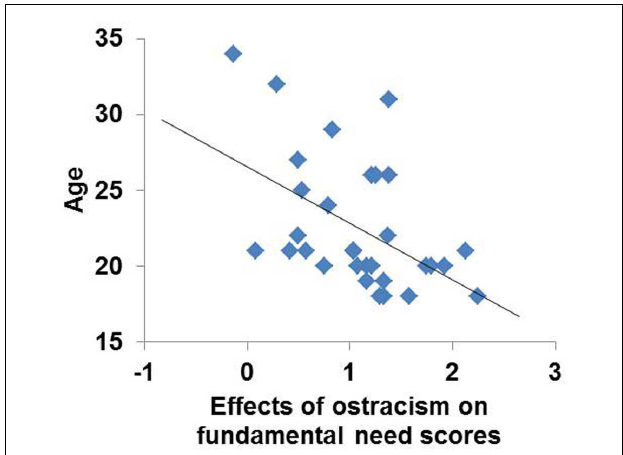
FIGURE 3 | Effects of simulated social ostracism on fundamental need scores were negatively correlated with age, accounting for 24% of the